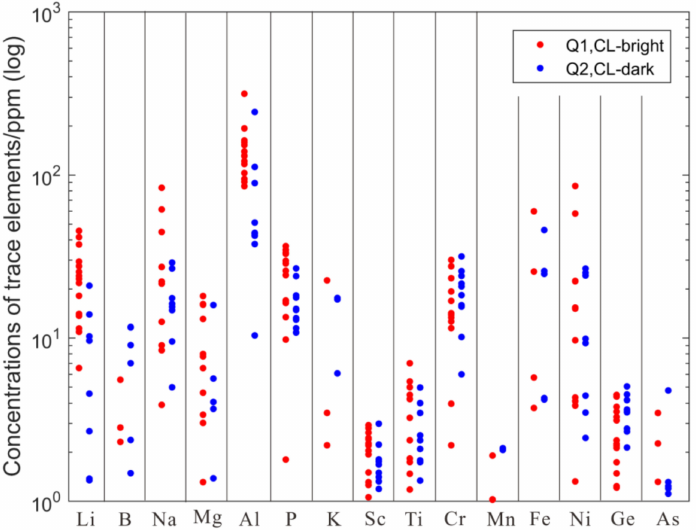
Figure 13. Concentrations of trace elements in the two generations of quartz Q1 and